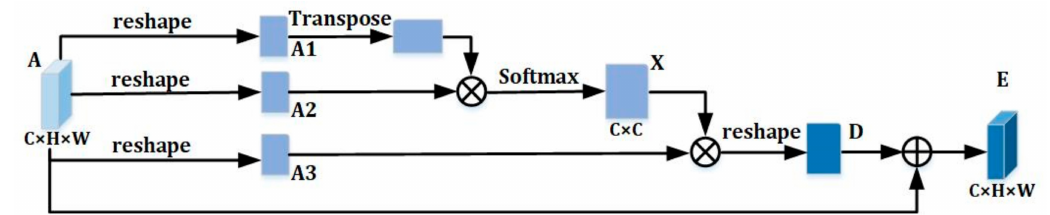
Figure 4. Channel attention module